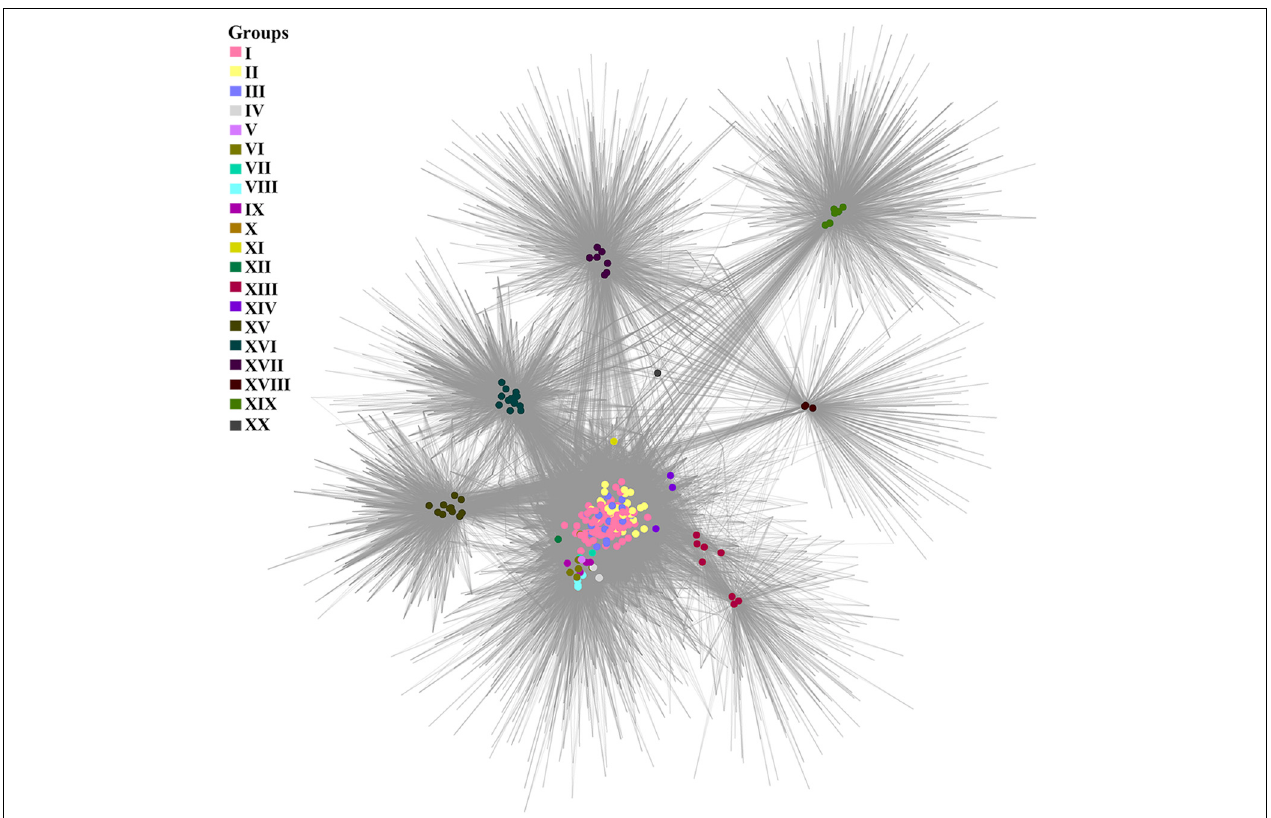
FIGURE 4 | A cluster-genome bipartite network of the pan-genome envelope of Tevenvirinae . Genomes that belong to the same cluster (group) are marked with colored circles. The connected nodes represent individual clusters of translated ORF